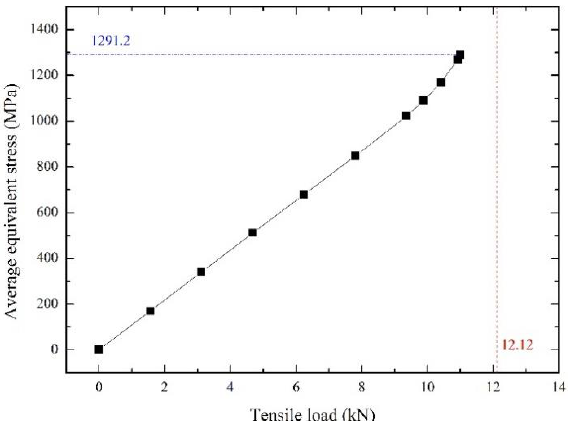
Figure 22. The variation of average equivalent stress with tensile load.